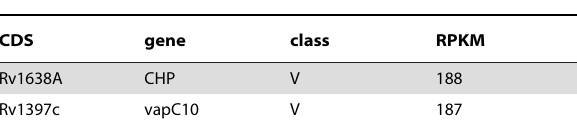
Table 3. Ranking of the most abundant coding transcripts in exponential